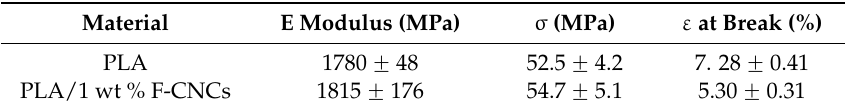
Table 3. Mechanical behavior of PLA-based nanocomposite films.